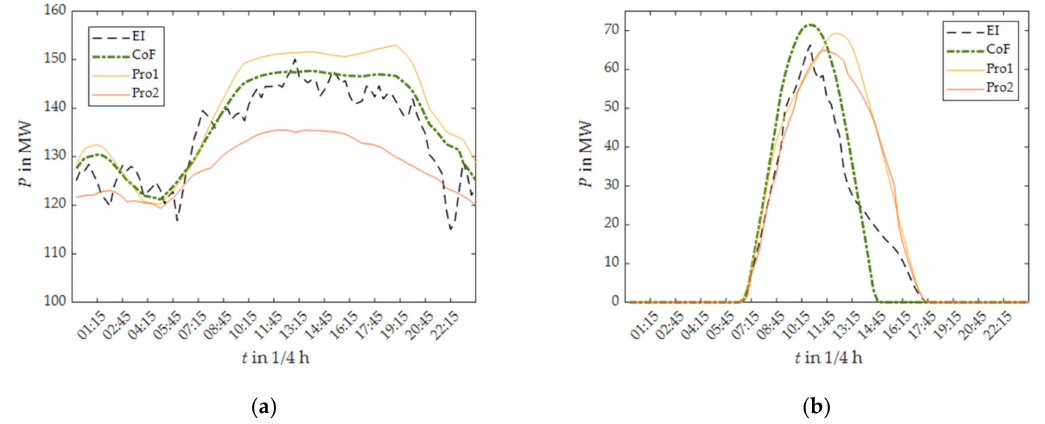
Figure 6. Results of the combination forecast (green line) in comparison with the extrapolated generation (black line) and provider forecasts (orange and yellow lines) for ( a ) wind and ( b )